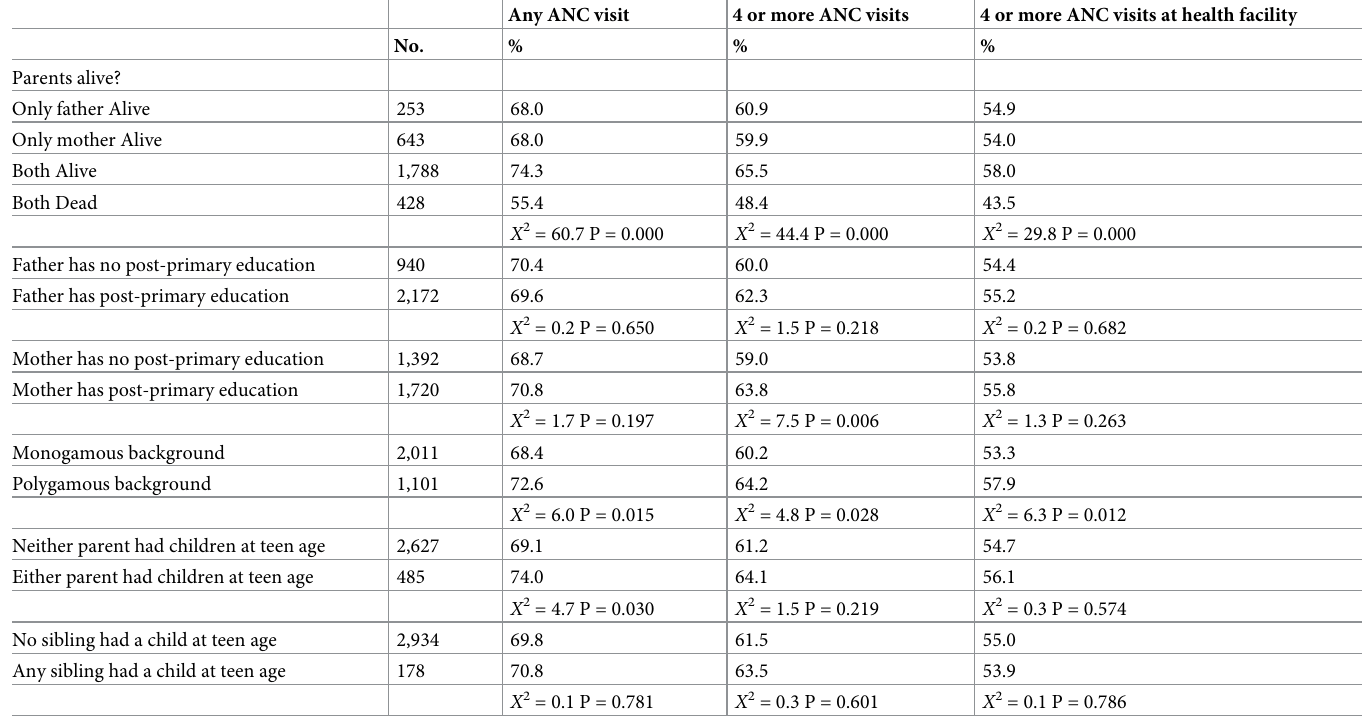
Table 4. Bivariate analysis between family variables and outcome